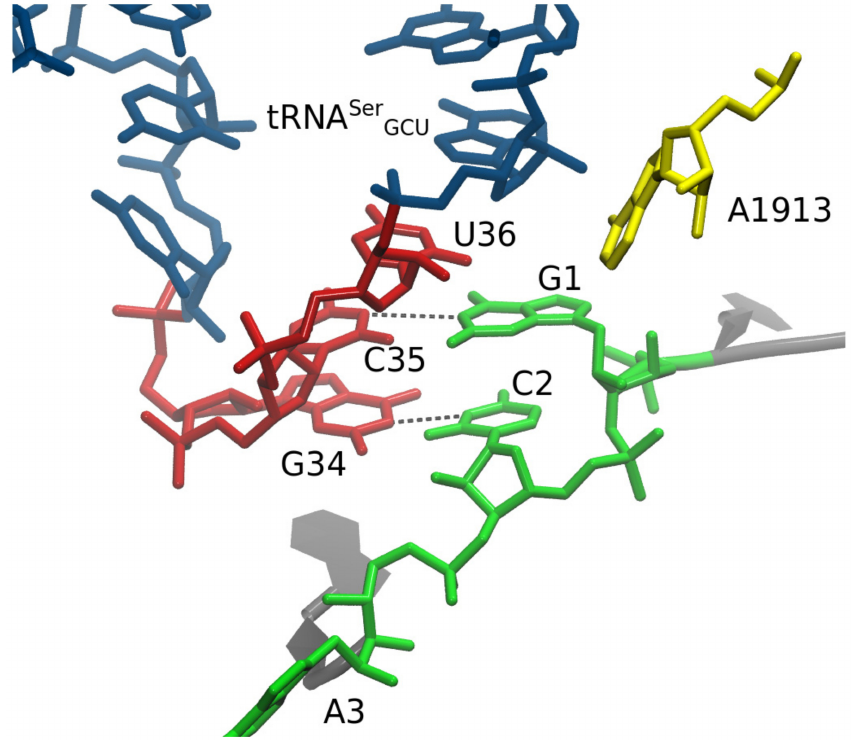
Figure 3. Construction of initial model under the doublet decoding hypothesis, using MacroMoleculeBuilder (MMB). Alanine GCA codon with tRNA 3Ser GCU. U36 is not engaged in any base pairing. Base pairs: (tRNA) G34 –C2 (mRNA); (tRNA) C35 –G1 (mRNA). Residues Y 35-36-37 have imposed helical